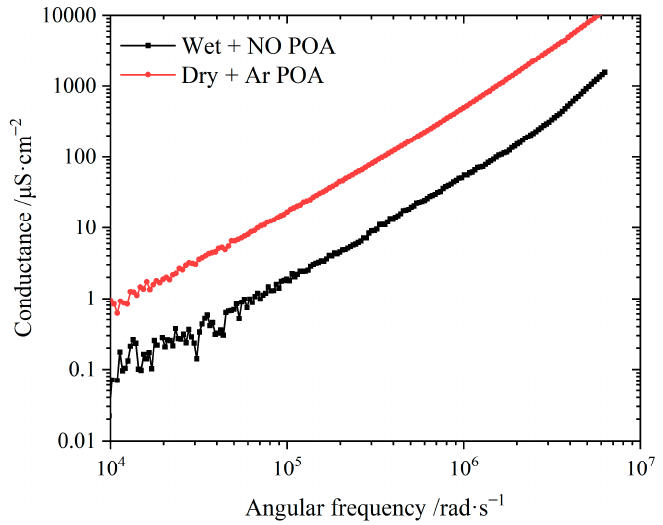
Figure 3. Conductance-frequency curves measured at accumulation state for the both samples.